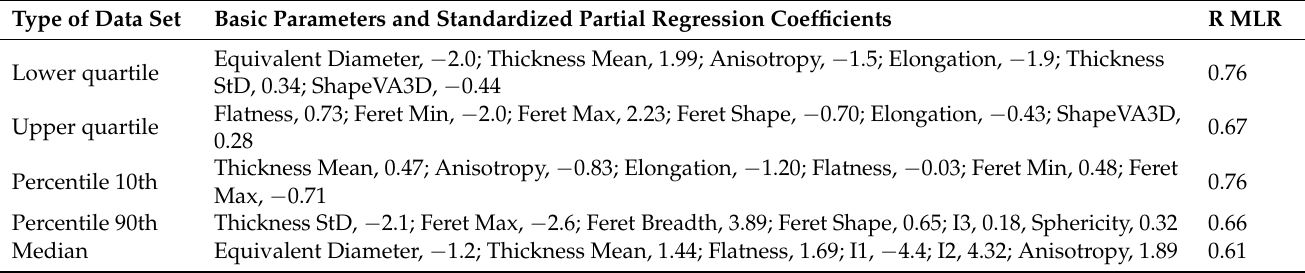
Table 3. Results of multiple linear regression on standard geometrical parameters from CT images based on different statistical data sets. Symbols: R MLR—correlation coefficient of multiple linear regression. Type of Data Set Basic Parameters and Standardized Partial Regression Coefficients R MLR Lower